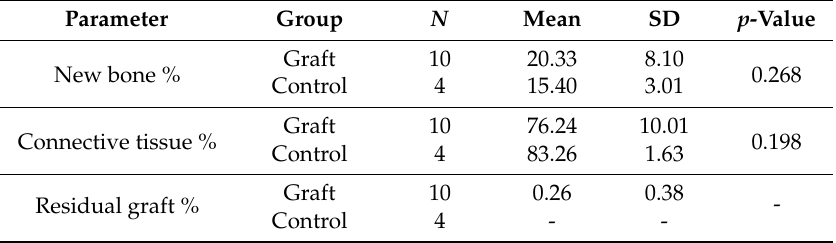
Table 3. Percentages of new bone, connective tissue and residual graft occupying the